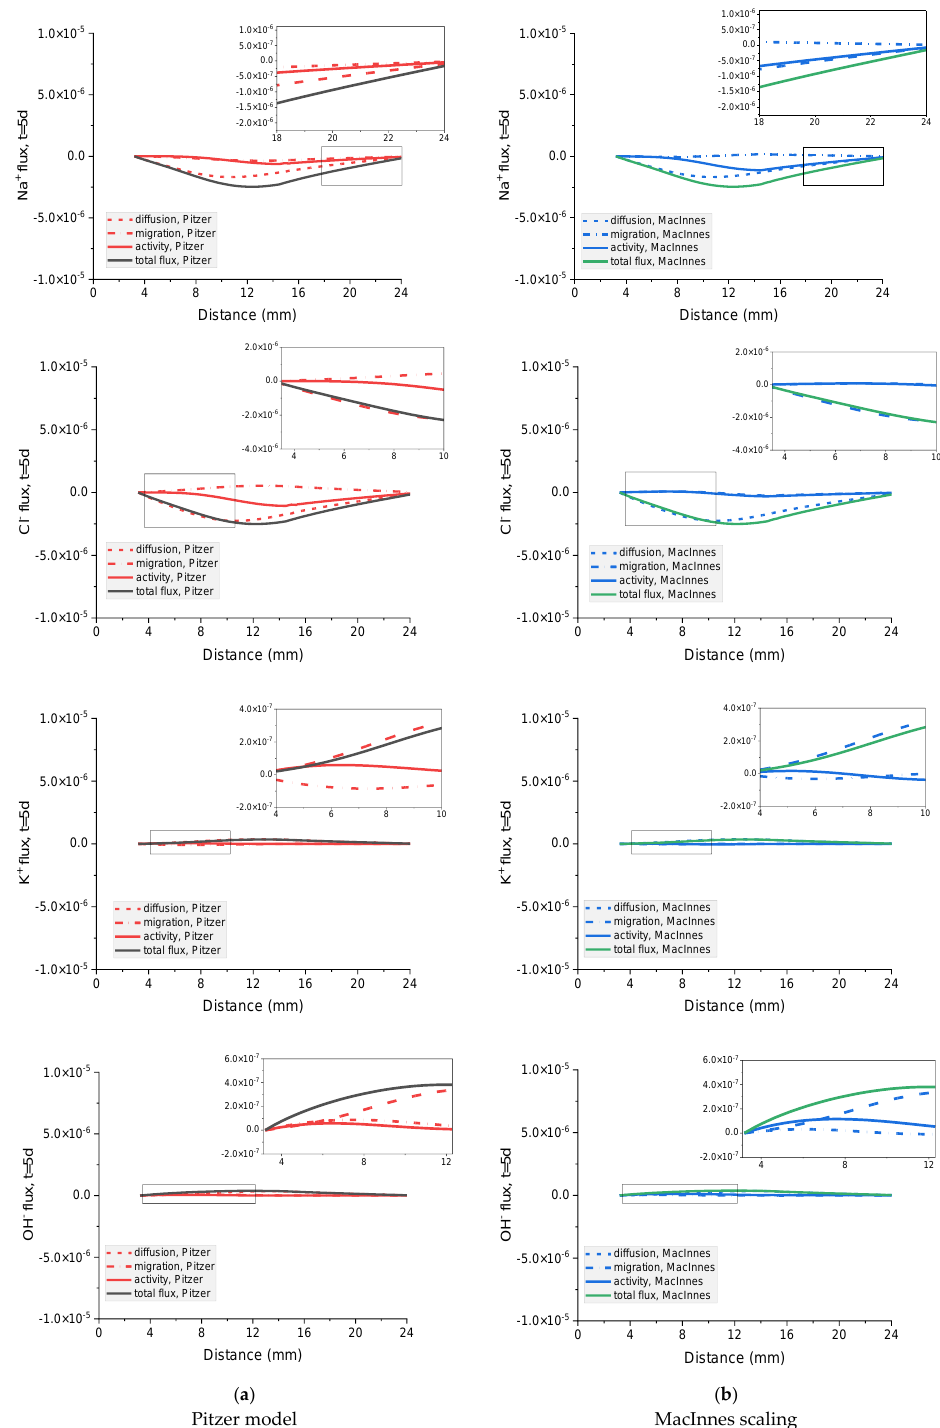
Figure 18. Influence of diffusion, migration, and activity terms on the total flux of Na + , Cl − , K + , and OH − ions in the mortar after 5 days immersion in 20 wt% NaCl water solution for ( a ) Pitzer and ( b ) MacInnes scaling.